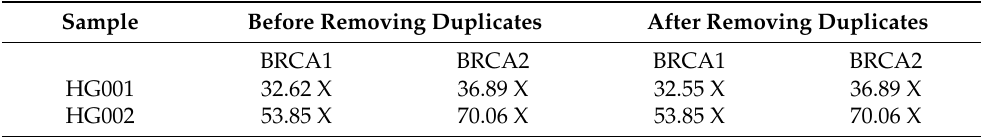
Table 2. The coverage difference before removing duplicates and after removing duplicates. Sample